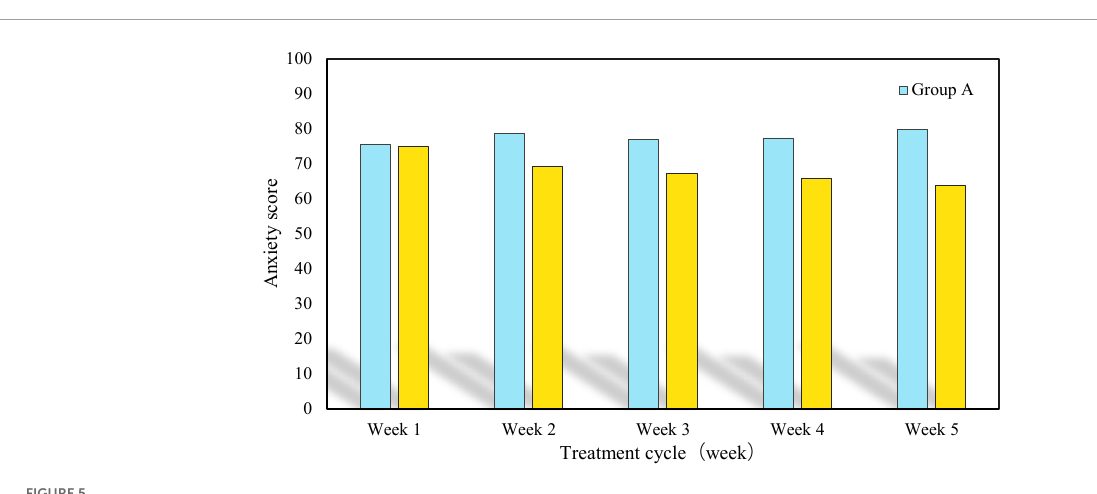
FIGURE5 Anxiety score of breast cancer patients within 5 weeks under two treatment methods.